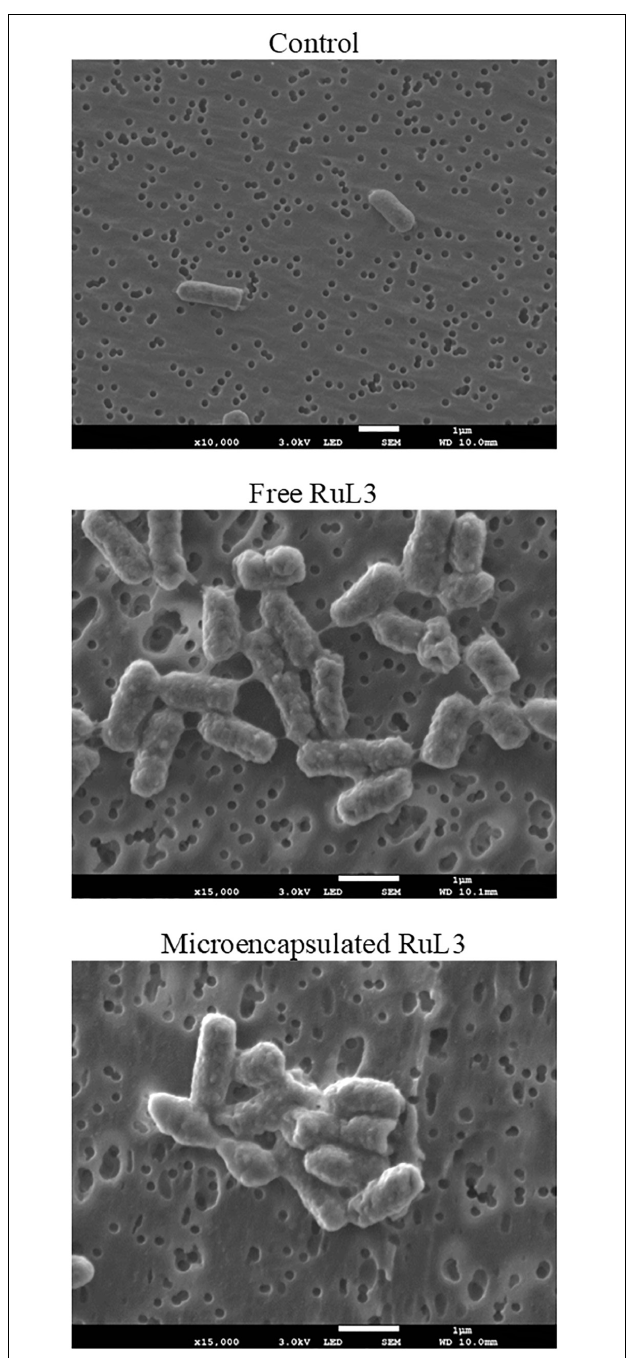
FIGURE 4 | Scanning electron micrographs of Escherichia coli biofilm cells, after treatment with free and micoencapsulated RuL3 at the MIC. The control represents cells treated with potassium phosphate